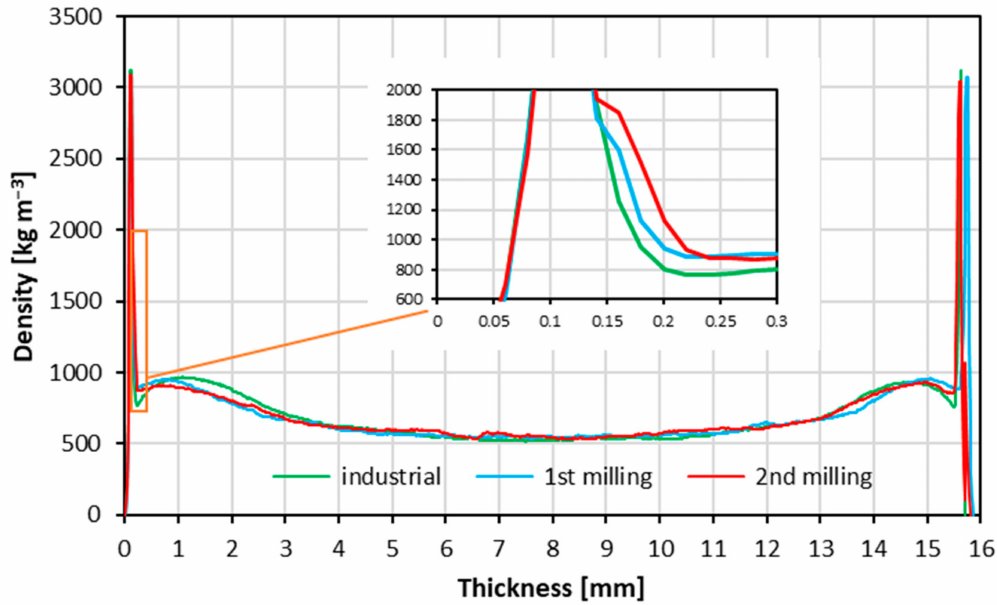
Figure 6. Density profiles of the panels produced using different